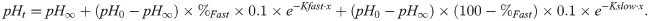
pH of culture media.(A) pH of culture media determined in a laminar flow hood after 2 days of Pi treatments. ANOVA, p < 0.0001. *Different from the corresponding Pi concentration in MEM with Tukey’s test. (B) pH of media after two days of Pi treatments on live and dead VSMC. ANOVA, p < 0.0001 for the four groups. Because there were no differences of pH values due to the Pi concentrations within each group, multiple comparisons were made using the means of each subgroup. All comparisons are significantly different with Tukey’s test. (C) Evolution of the pH of newly made media in 24-well plates inside a 5% CO2 incubator. The experimental pH values were fitted to an exponential decay curve, pH
t = (pH
0 − pH
∞) × e
−k∙x + pH
∞, by nonlinear regression, where pH0 is the pH at time 0 (in the hood) and pH∞ is the lowest pH reached, i.e., the plateau. Constant rates (k) and r2 are also shown for each fit. (D) Evolution of pH in the hood when cultures were moved from the 5% CO2 incubator. After 0.5 minutes of rapid rise, the pH rose more slowly, and therefore the data were fitted to a two-phase exponential equation:
pHt=pH∞+(pH0−pH∞)×%Fast×0.1×e−Kfast∙x+(pH0−pH∞)×(100−%Fast)×0.1×e−Kslow∙x.
The constant rates in the figure refer to the slow (long) phase, while the r2 corresponds to the whole fit. (E) Evolution of pH in MEM containing 1–3mM Pi during the calcification of VSMC for 12 days. Measurements were made inside a 5% CO2 incubator. An ANOVA was conducted for each determination day. *Different from the corresponding 1mM Pi pH value. (F) Variation of the relative concentration of different phosphate species in solution according to the pH. The PO4
3- ratio corresponds to the right vertical axis.